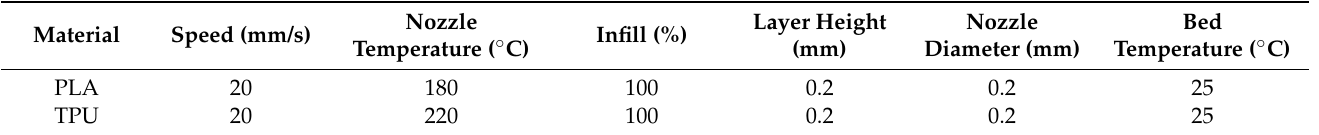
Table 1. Parameters for 3D printing of PLA/TPU polymers.